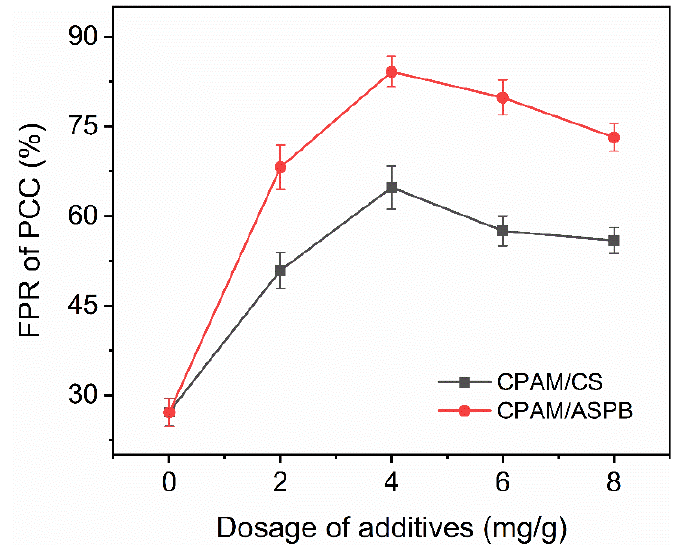
Figure 8. Retention of precipitated calcium carbonate (PCC) in the dual-component system. CPAM fixed at 1.5 mg/g.